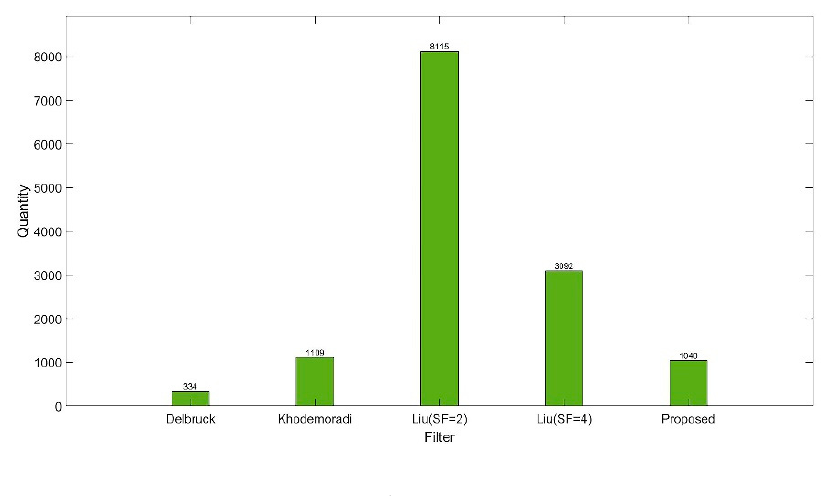
Figure 13. The noise in real ( top ) and real in noise ( bottom ) of the five filters in this time period.